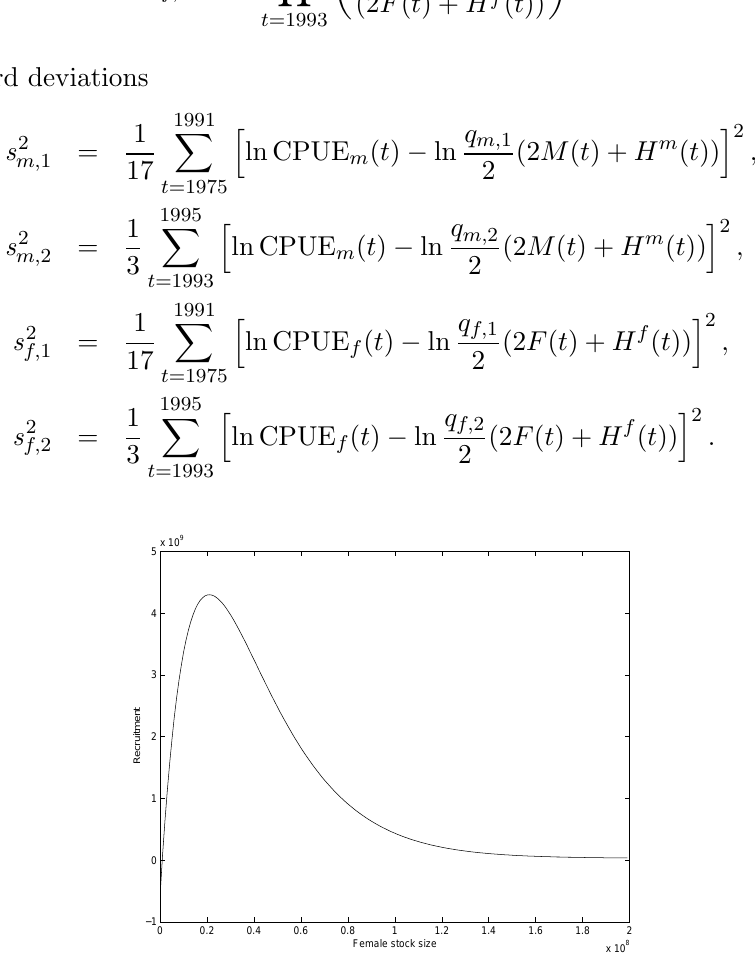
Figure 6: The proposed recruitment function for the application to the Cape Rock Lobster resource, namely Z ( S m , S f ) = κ + β ( S f − δ ) e ( − ωS f ) . The parameters are taken as κ = 3 . 0 × 10 7 , β = 610 , δ = 1 . 0 × 10 6 , ω = 5 . 0 × 10 − 8